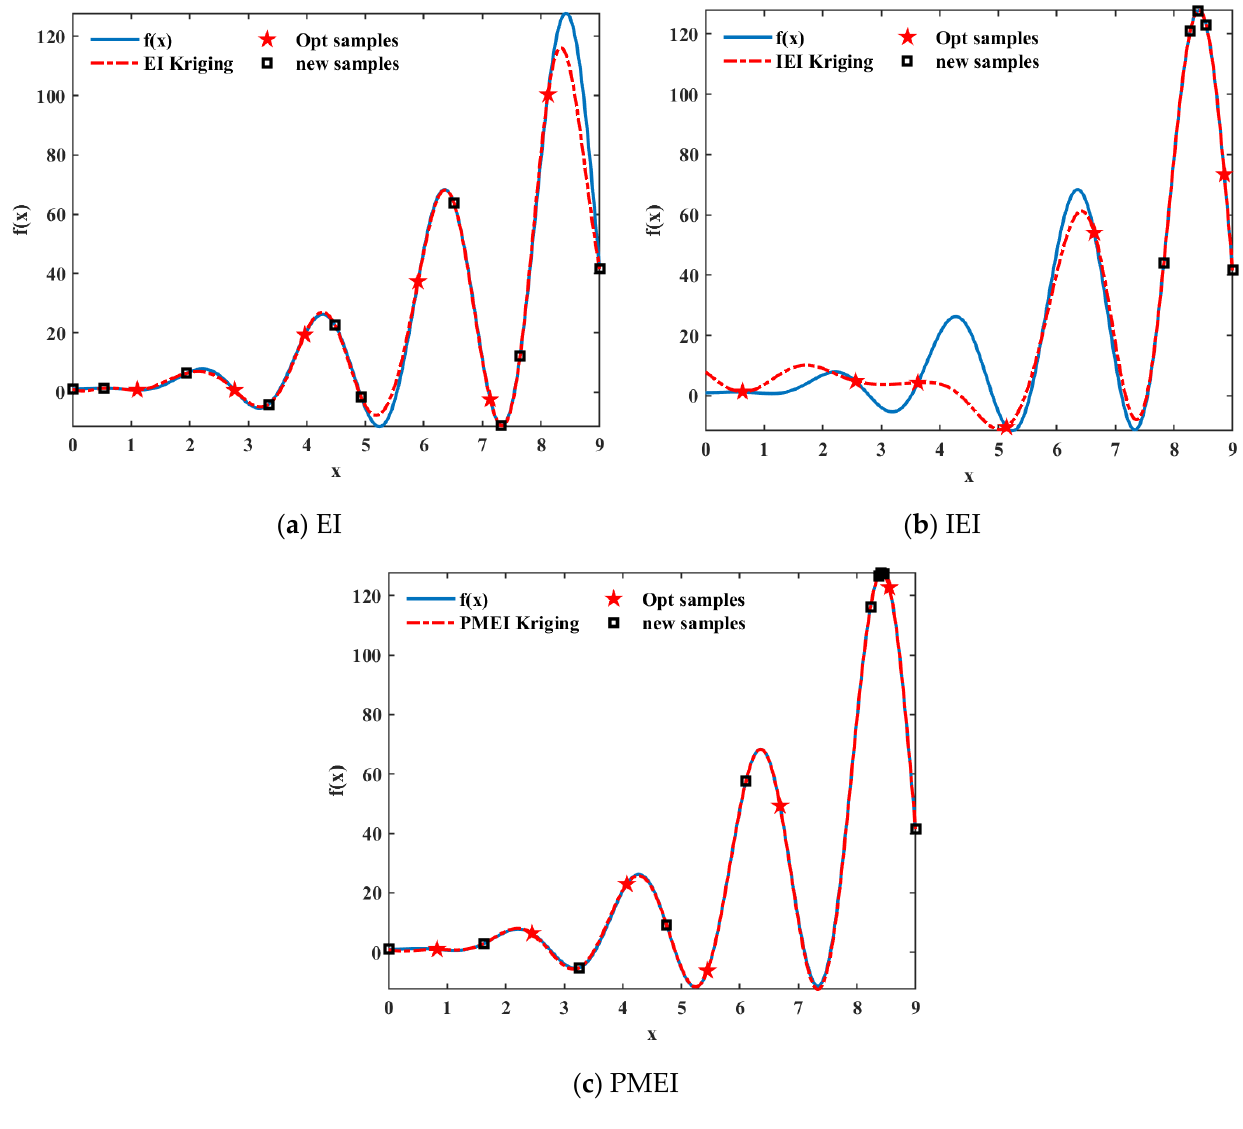
Figure 2. The Kriging curve of one-dimensional function.